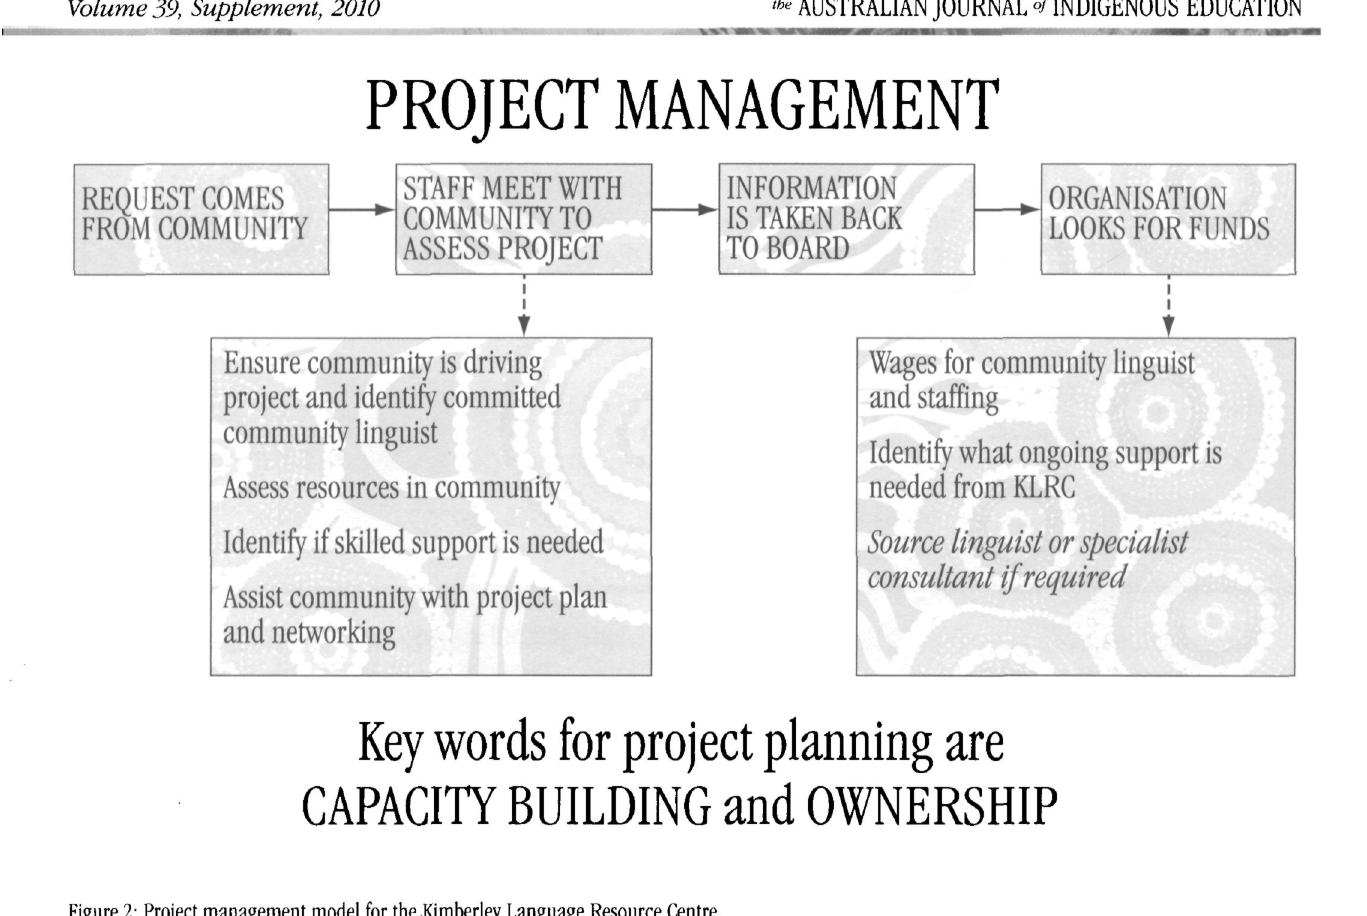
Figure 2: Project management model for the Kimberley Language Resource